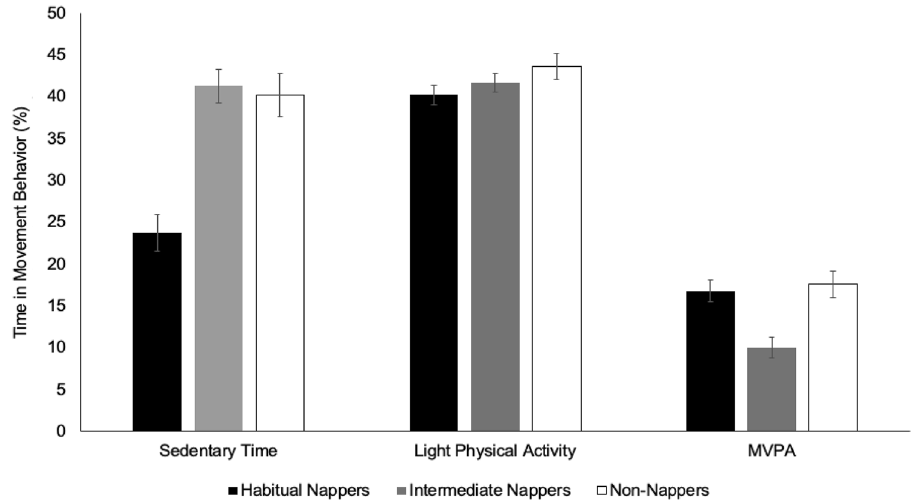
Figure 2. Adjusted means and standard errors of habitual wake behaviors by nap habituality group. ( MVPA moderate- to vigorous-intensity physical activity).